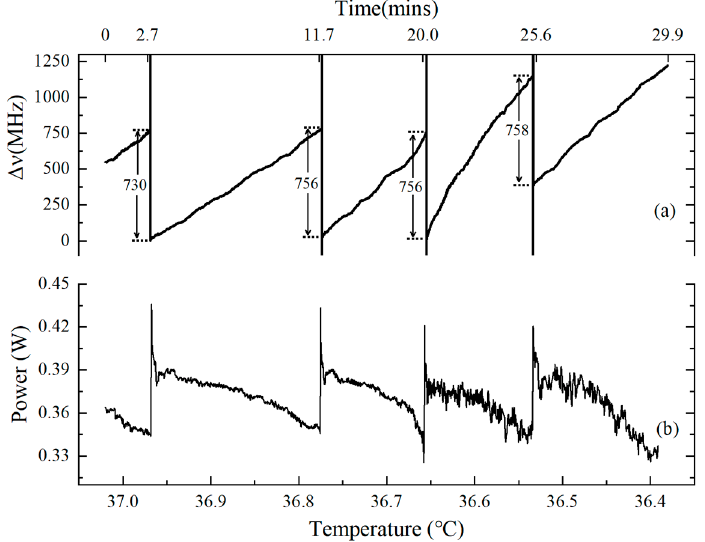
Figure 7. ( a ) Mode hops of signal beam provoked by the temperature of the base plate and ( b ) corresponding idler power. The reference point of the frequency is 201.71606 THz.